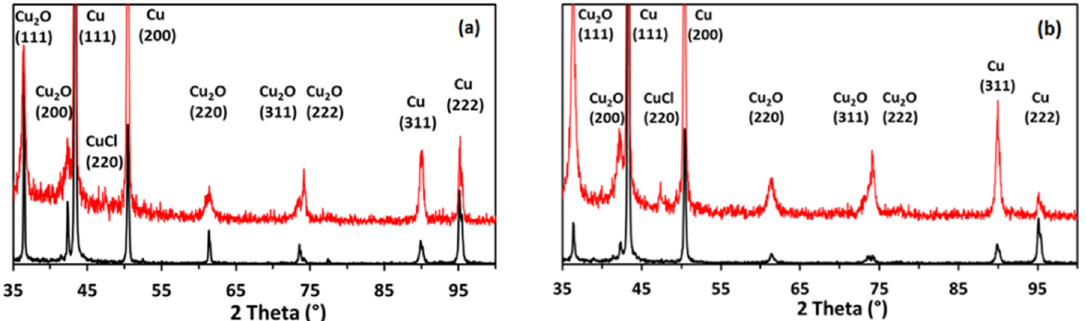
Figure 10. The XRD patterns of ( a ) CF-18H and ( b ) CF-18H-100U before electrolysis (bottom black pattern) and post 35 min electrolysis (top red pattern), offset for clarity. For each material, both spectra were normalized to their respective Cu(111) peak and scaled to the “before electrolysis” Cu(111) peak.